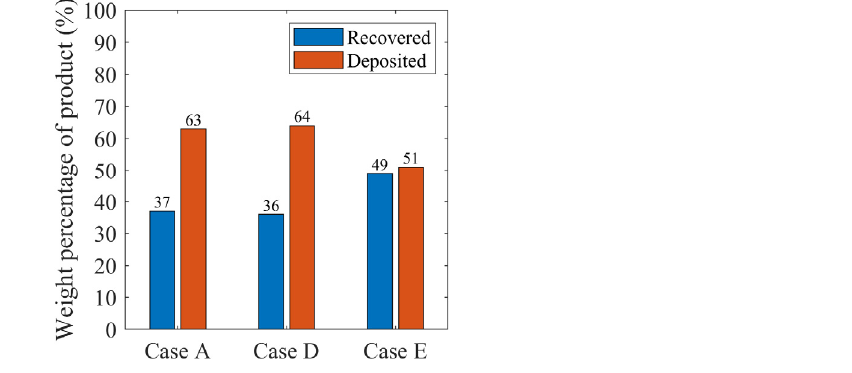
Figure 12. Product recovery at outlet and deposition in the dryer for cases A, D and E.